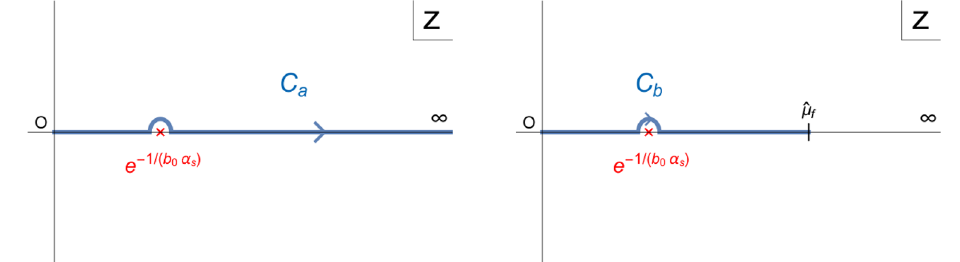
Figure 2 . Contours C a and C b in eq.